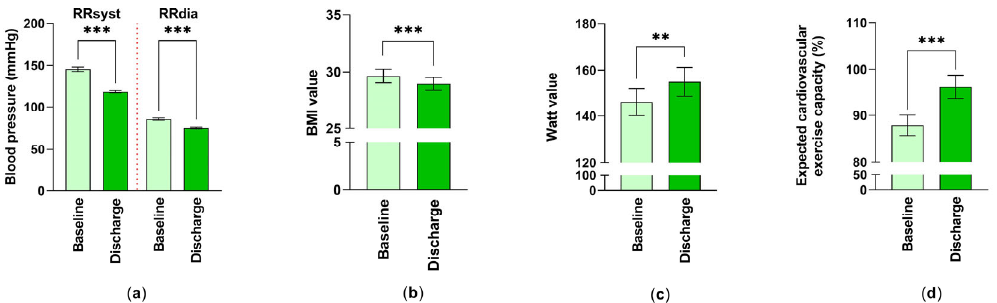
Figure 1. The effect of inpatient cardiac rehabilitation on physiological parameters: ( a ) Differences in systolic and diastolic blood pressure are shown. Mean ± standard error of mean (SEM) are given. ***: p < 0.001 (n syst, dia = 59); ( b ) Changes in BMI values were examined. Values were expressed as mean ± SEM. ***: p < 0.001 (n = 59); ( c , d ) Values of cycle ergometry were studied. Measured Watt- values (n = 52) and expected cardiovascular exercise capacity (%) (n = 56) at baseline and at discharge expressed as averaged data ± SEM. Statistical analysis for these comparisons were performed. **: p < 0.01, ***: p < 0.001.